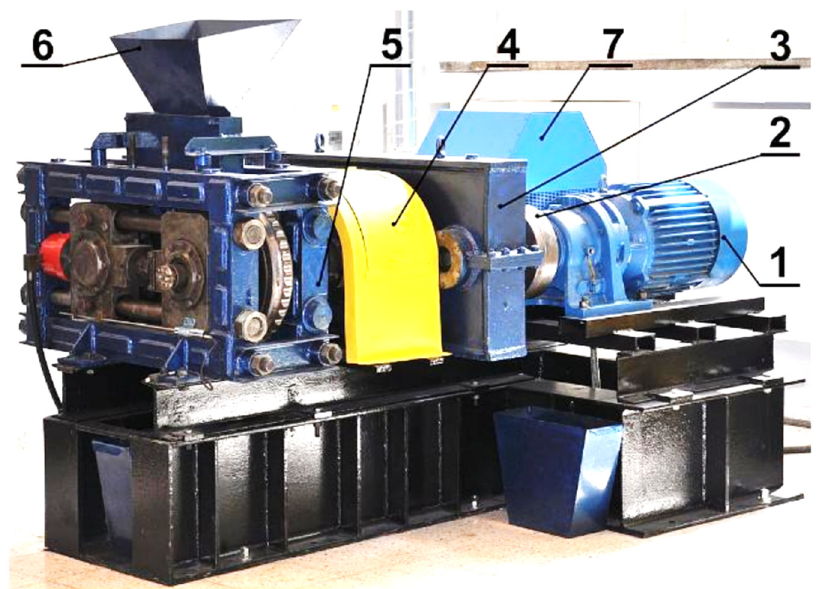
Figure 2. LPW 450 laboratory roller press: ( 1 ) gear motor with a cycloidal transmission; ( 2 ) flexible clutch; ( 3 ) gearbox; ( 4 ) enclosure of Oldham couplings and friction clutch; ( 5 ) molding rollers cage; ( 6 ) gravity feeder; ( 7 ) hydraulic system of sliding roller support [69].